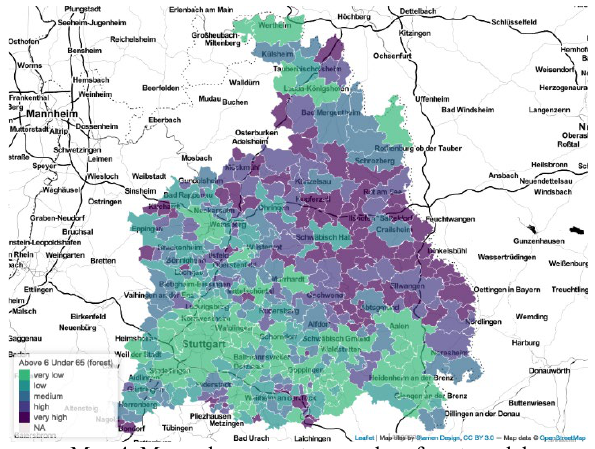
Figure 5. Pruned tree bushiness tax per capita